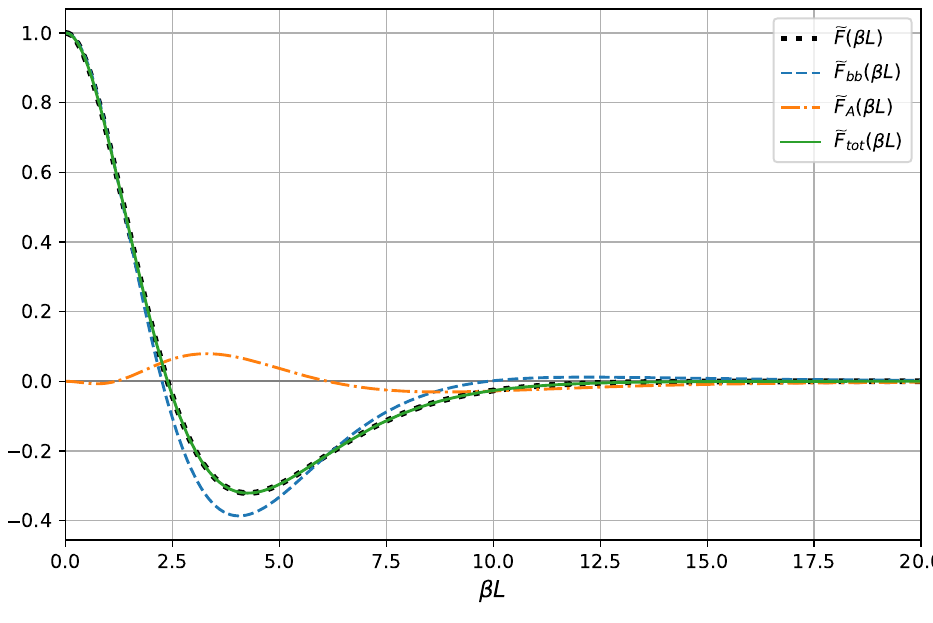
Figure 4 . The relative Casimir force e F tot ( βL ) and its contributions e F A ( βL ) and e F case of equal boundary conditions θ + = θ − . The relative Casimir force in a homogeneous chiral medium e F ( βL ) is also shown for reference.